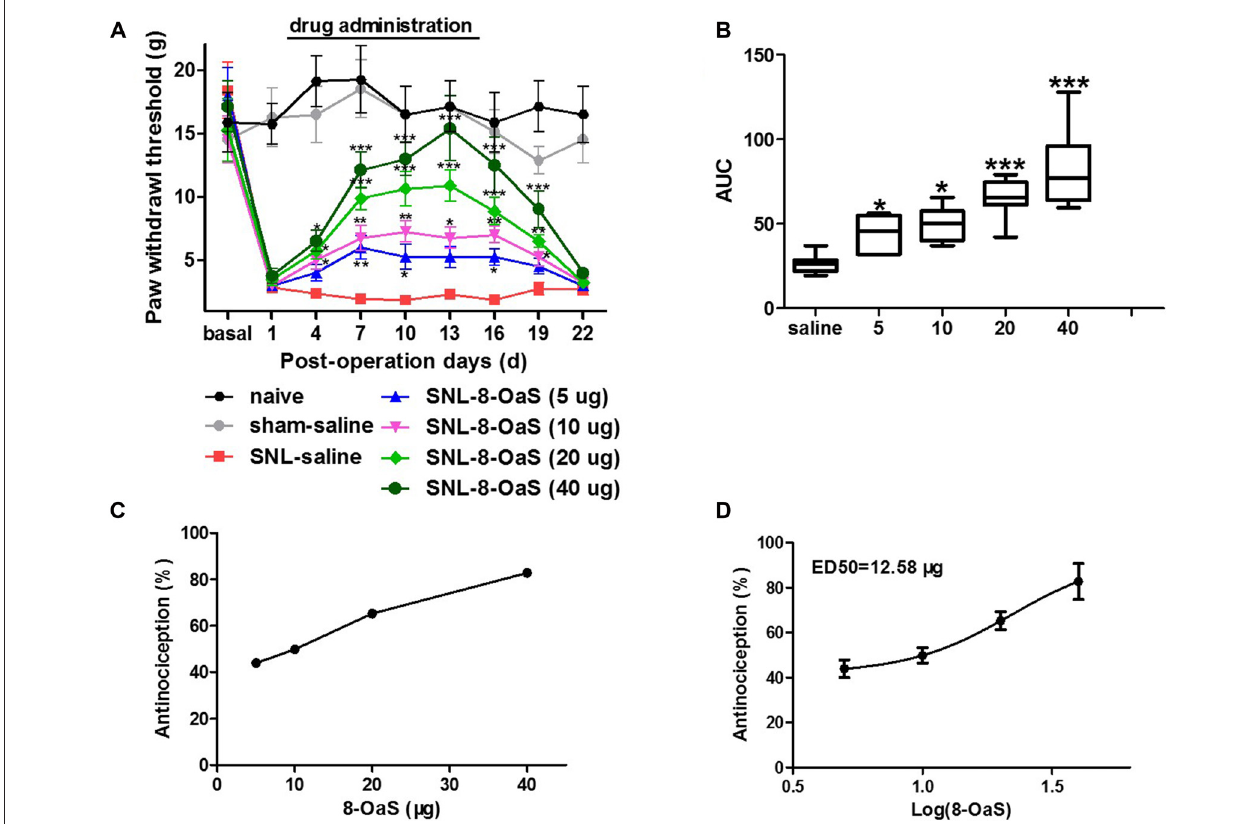
FIGURE 1 | Effects of consecutive intrathecal administration of 8-O-acetyl shanzhiside methylester (8-OaS) on spinal nerve ligation (SNL)-induced mechanical hypersensitivity. The time course of analgesia by different doses of 8-OaS (A) . The area under the time-course curves (AUCs) of the analgesic effects for different doses of 8-OaS (B) . The dose effect or log (dose) effect curves for the analgesic effects of 8-OaS are shown in (C,D) , respectively. ∗ P < 0.05, ∗∗ P < 0.01 and ∗∗∗ P < 0.001, compared with the SNL-saline group. n = 8 in each group.